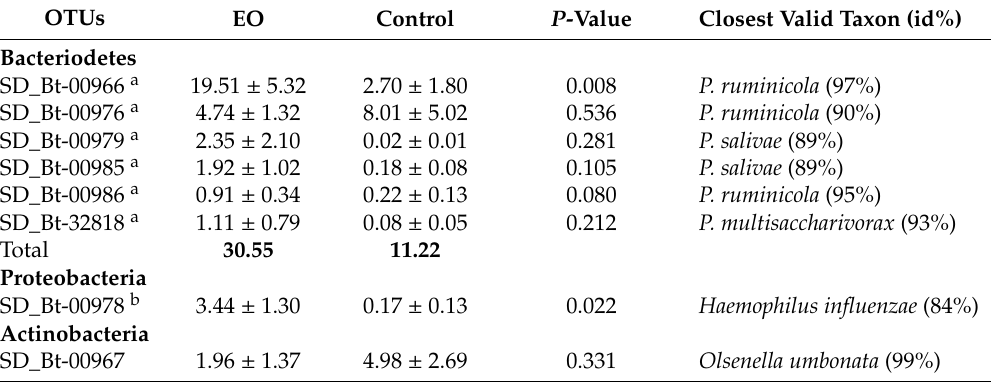
Table 3. Relative abundance (%) of main operational taxonomic units (OTUs) assigned to Bacteriodetes, Proteobacteria, and Actinobacteria in rumen samples collected from dairy calves fed an EO-supplemented or control diet. Values shown represent mean and standard error of the mean, respectively.